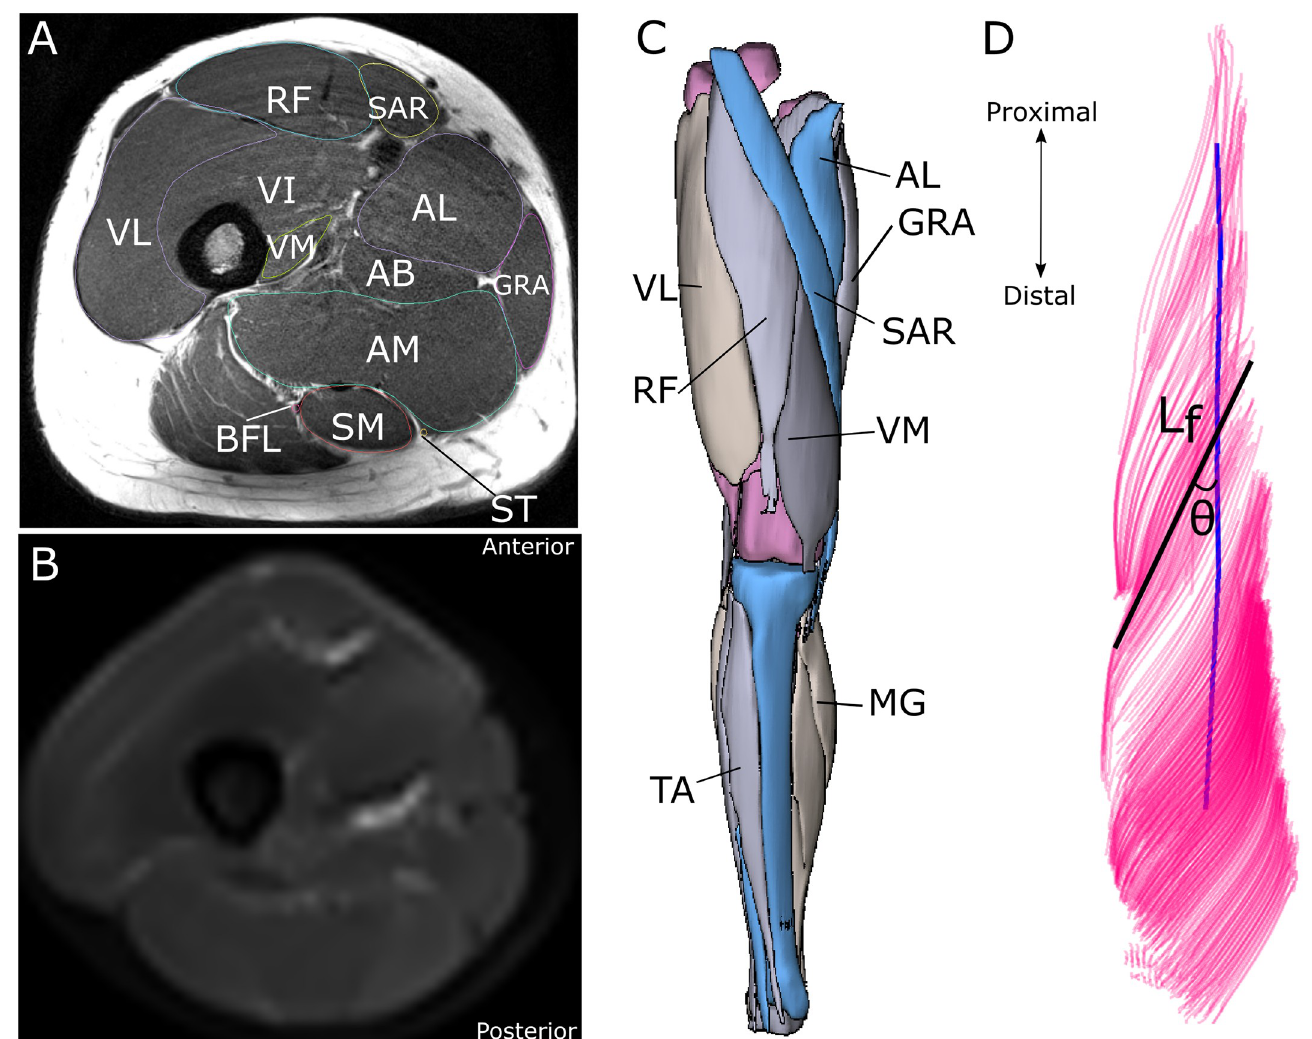
Fig 1. Representative T1-weighted MR anatomical image (A) and diffusion tensor image (B) of the thigh segment of one subject. Muscles and bones were digitally segmented from the T1 images to create 3D representations of the lower limbs (C) (for muscle abbreviation definitions, see Table 2). Muscle fascicles (fibers) were tracked from the diffusion weighted MR images (D). From these 3D point cloud-based models, it was possible to measure fiber length (L f ) and surface fiber pennation angle ( θ , angle of the fibers relative to the muscle’s line of action (blue line)).